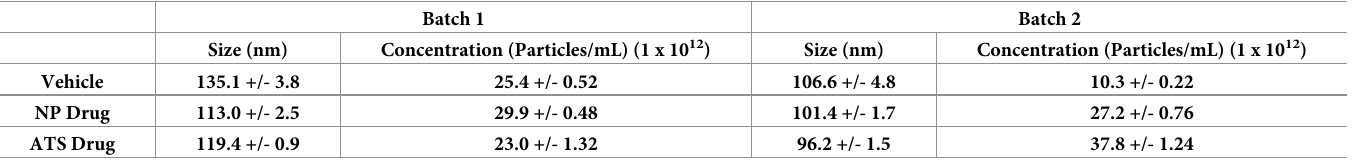
Table 4. Liposome